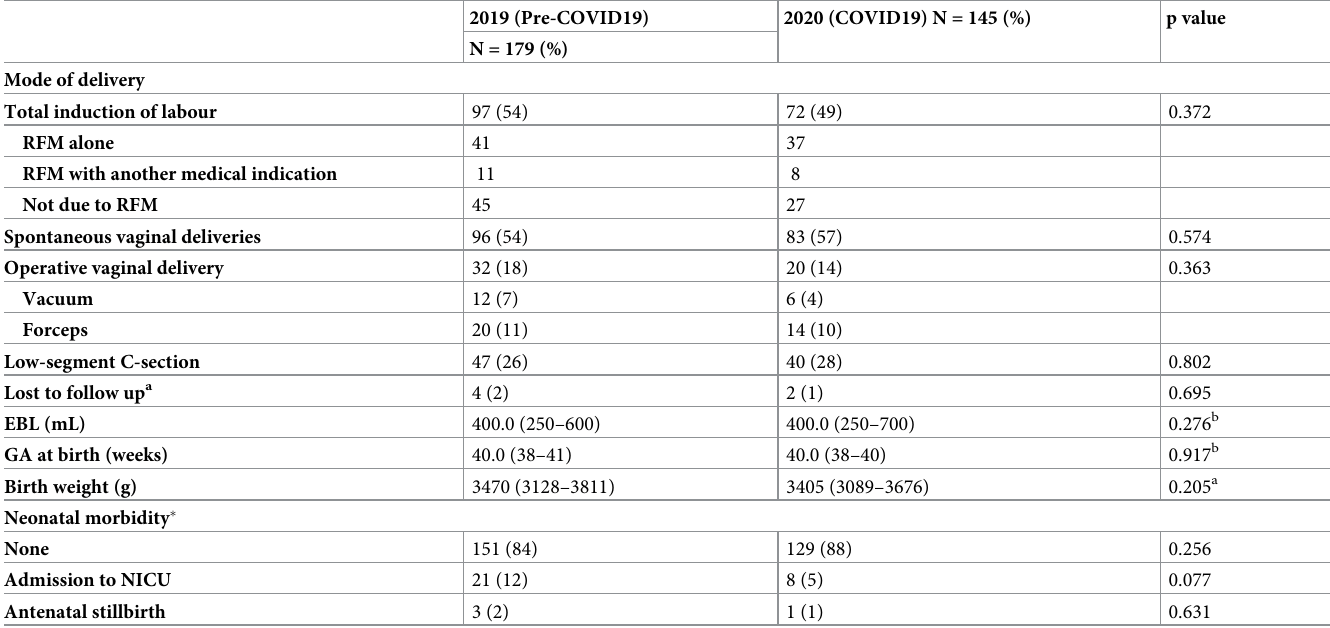
Table 3. Pregnancy and neonatal outcomes.